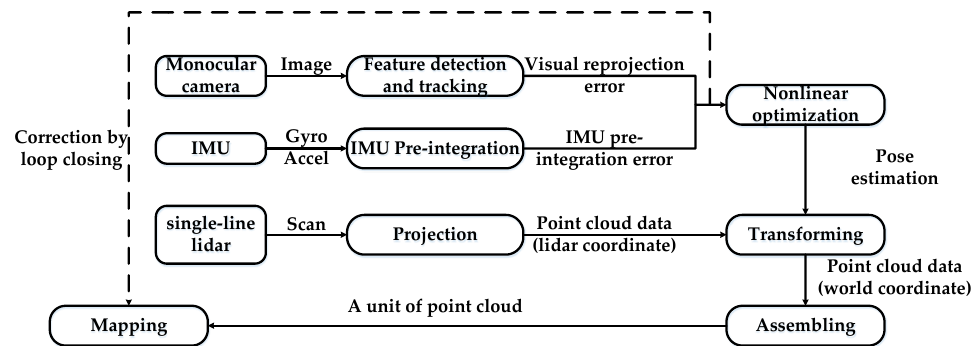
Figure 2. The overall framework of forest point cloud real-time reconstruction method with a single-line lidar based on visual – IMU fusion.